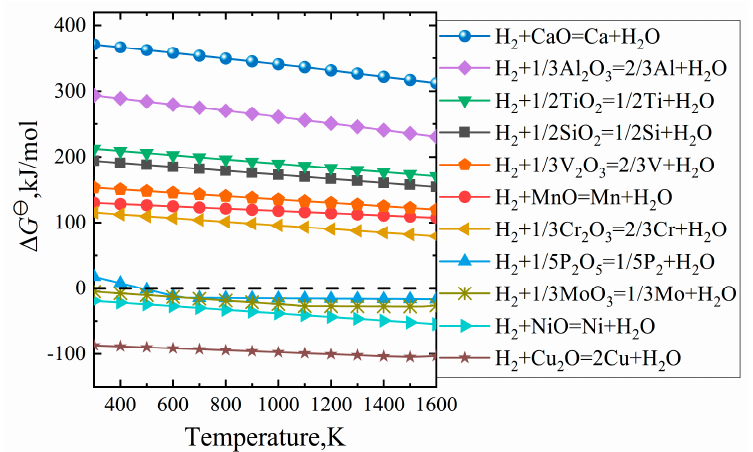
Figure 3. The standard Gibbs free energy change for the reactions of hydrogen with various oxides that may exist in ores.